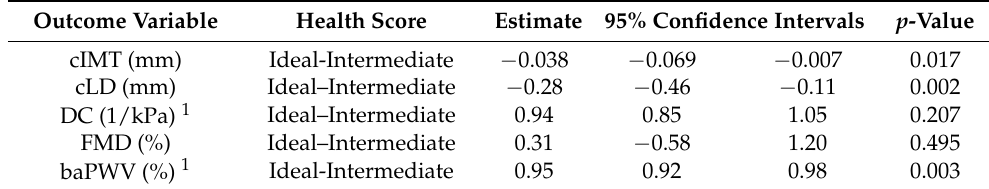
Table 2. Estimated mean difference or ratio of geometric means of the arterial properties between ideal and intermediate cardiovascular health score. Based on multiple imputation models. Adjusted for age and